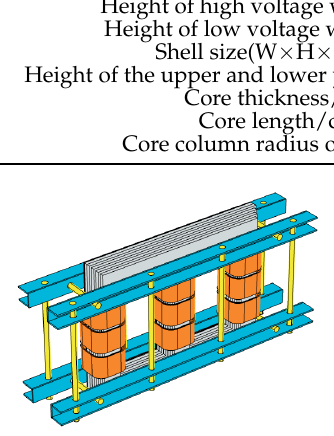
Figure 3. 3–D model of power Figure 3. 3 − D model of power transformer.